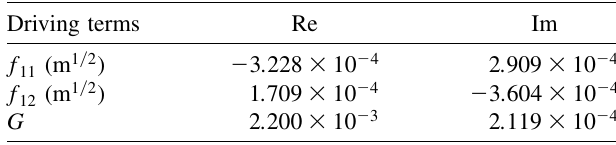
TABLE I. Estimation of stop band integrals. Driving terms